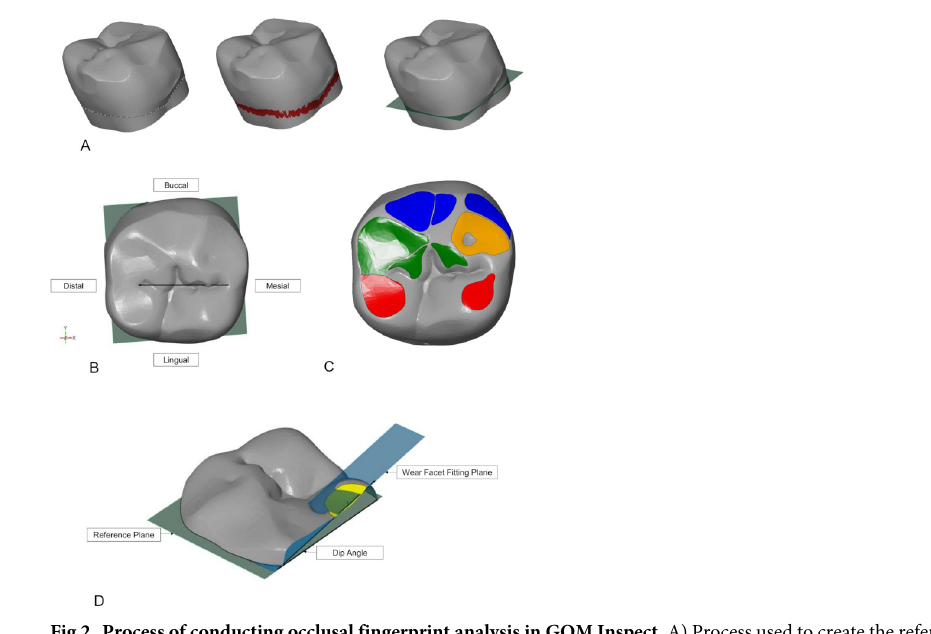
Fig 2. Process of conducting occlusal fingerprint analysis in GOM Inspect. A) Process used to create the reference plane through the cervix of the tooth. B) Correct alignment of a lower left molar using the cervical reference plane and mesio-distal axis of the tooth. C) A tooth with the wear facets demarcated using surface curves and colored according to their functional role during the power stroke: blue indicates buccal phase I, orange corresponds to lingual phase I, green to phase II and brown is a tip crushing area. The orientation of the tooth is the same as in diagram B. D) Illustration of how dip angle was calculated. The angle between a best-fit plane fitted to the wear facet and the cervical reference plane was measured to give the dip